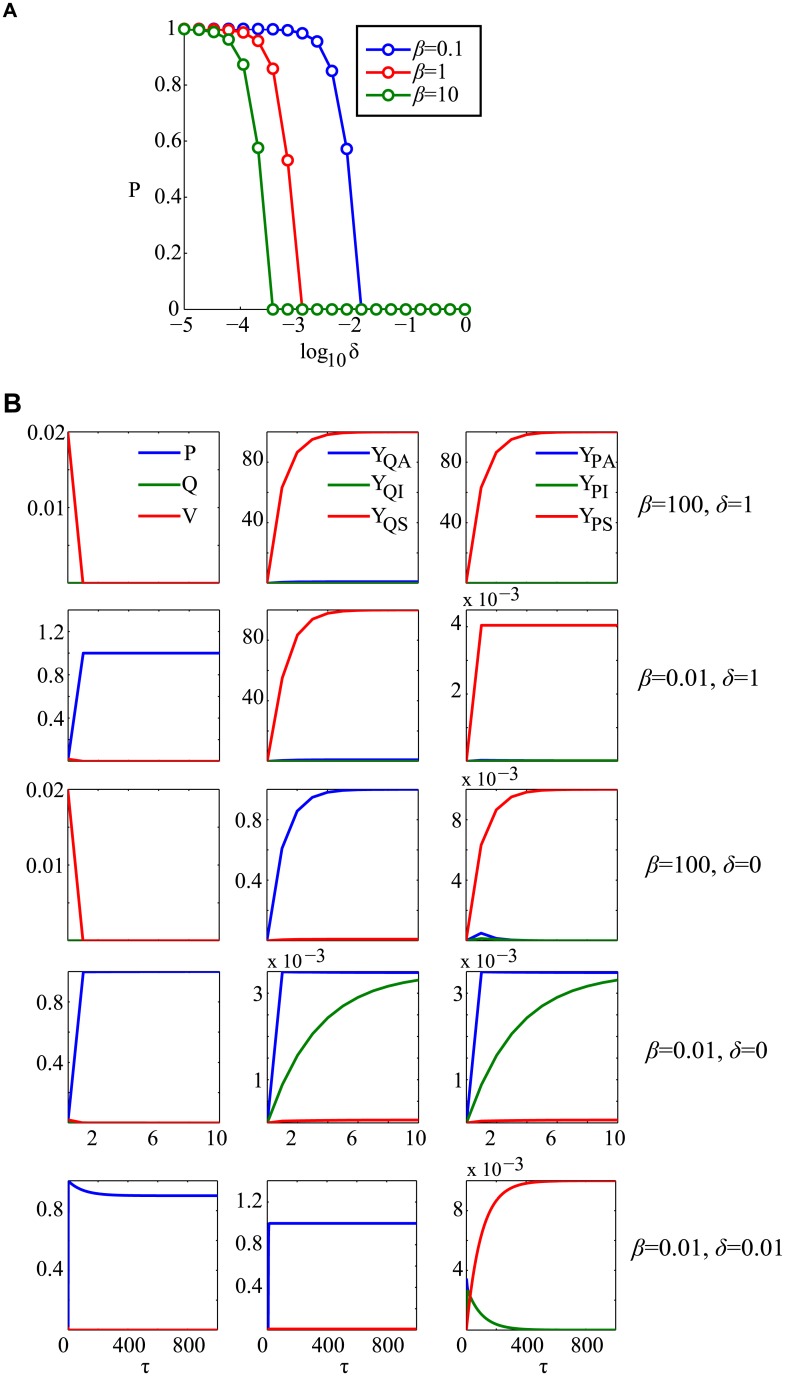
SND absence is lethal due to accumulation of self-targeting spacers.(A) A sharp threshold-like behavior is observed with steady state prokaryotic densities in the (δ,β)space. Without a sufficient amount of CRISPR suppression in free cells, determined by δ, cells go extinct. (B) Time course trajectories of the species and spacer variables for several parameter settings. In the absence of strong regulation of auto-immunity, high host protospacer levels are extremely toxic and cause population extinction.